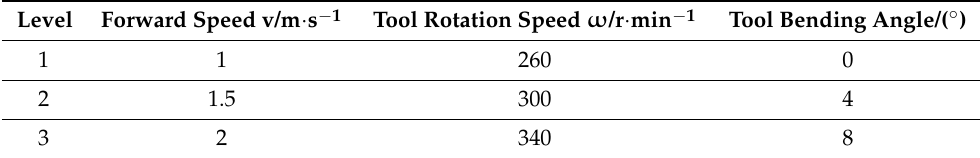
Table 4. Factors and levels of the orthogonal test.